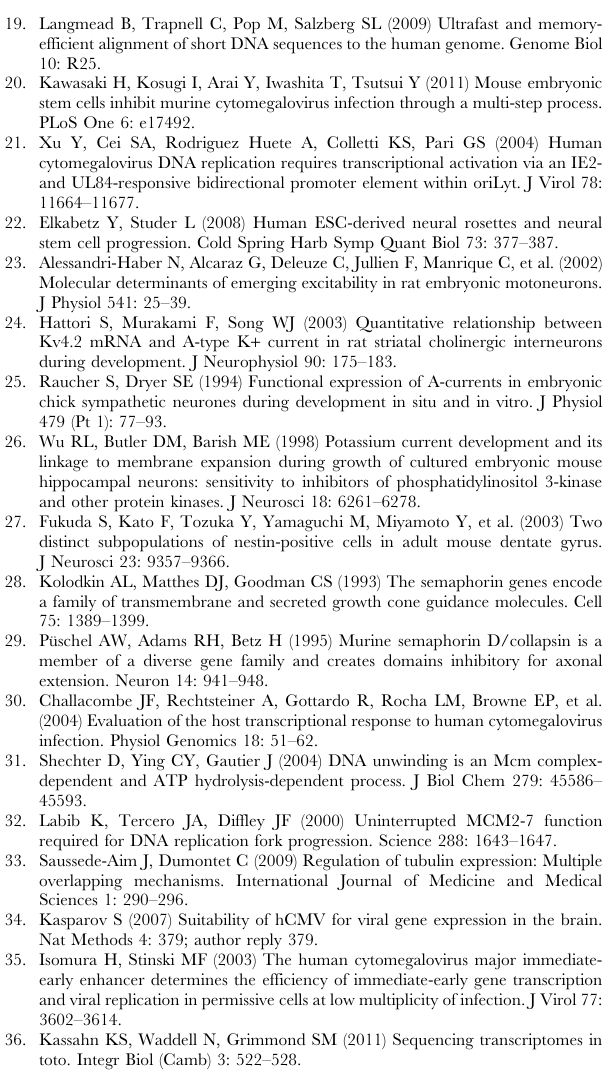
Table S1 RNA-Seq analysis of HCMV transcripts in infected